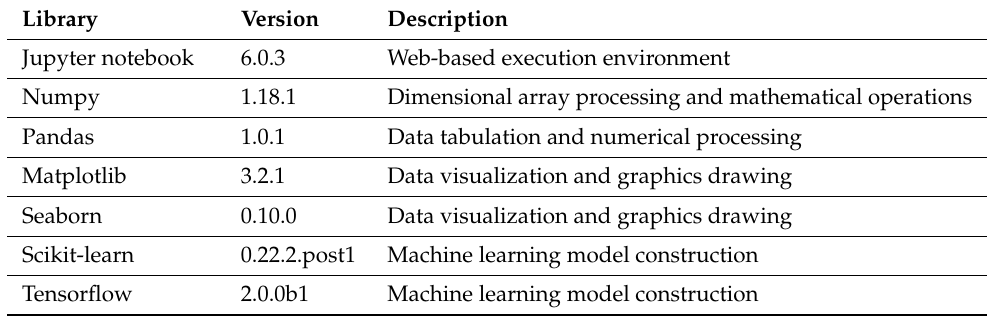
Table 6. Description of used